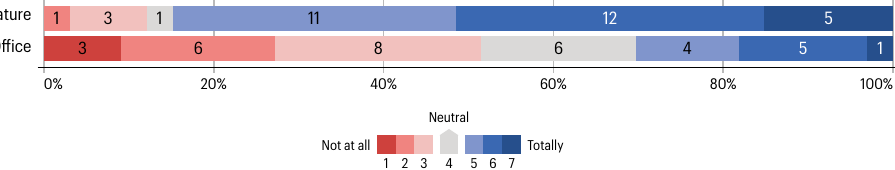
Figure 7. Ratings of preference for Nature and the Office. For a virtual working environment, participants prefer Nature more than an Office.